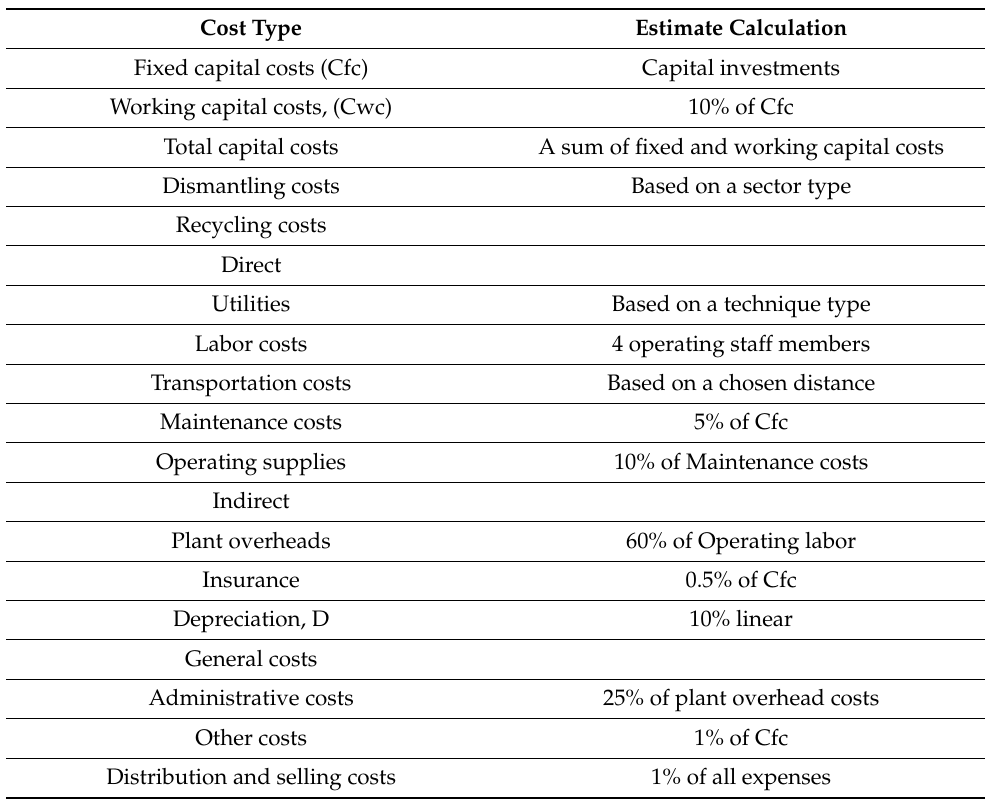
Table 2. Cost input data